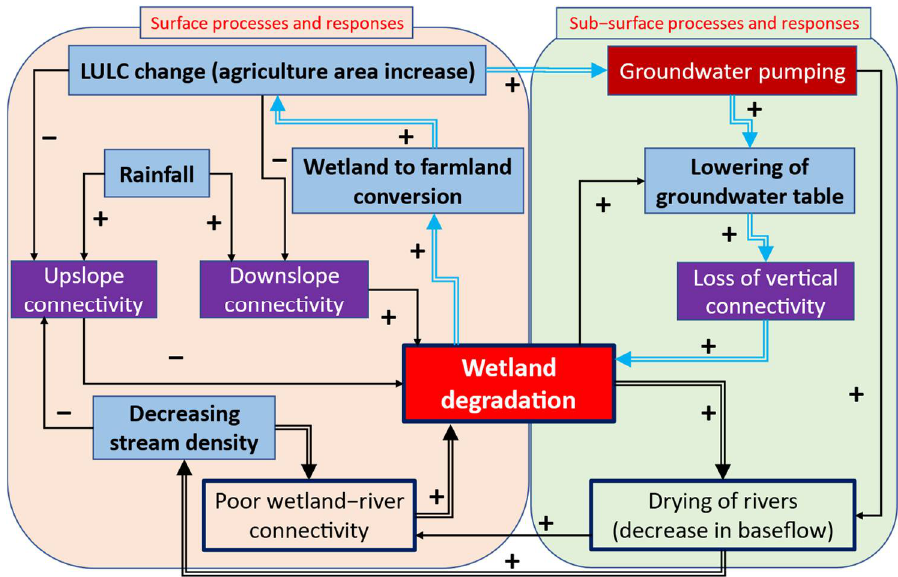
Figure 8. Interdependency of wetland degradation factors. Note the positive feedback among several factors responsible for wetland degradation represented by double-lined arrows. Two colours of the double-lined arrows represent two different positive feedback loops that are operating.